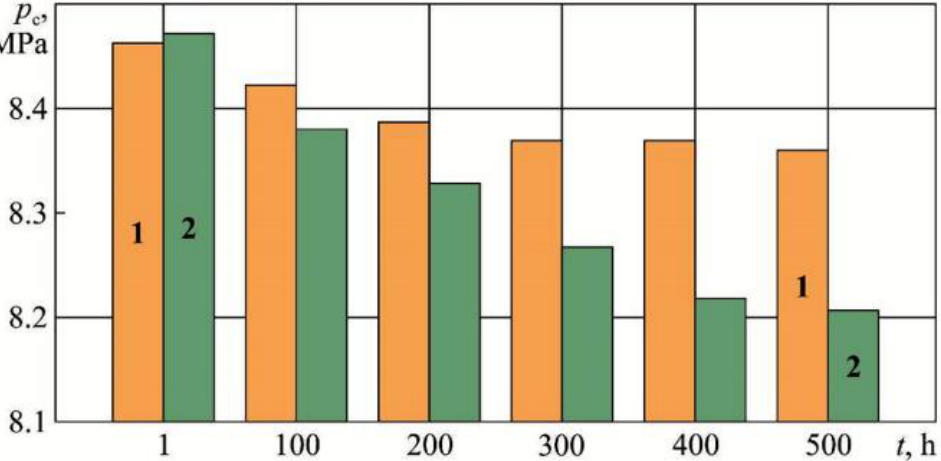
Figure 9. Compression pressure change, p c , MPa, diesel 5L23/30 MAN-B&W Diesel Group under different experimental conditions: 1 — diesel AE 1; 2 — diesel AE 2.